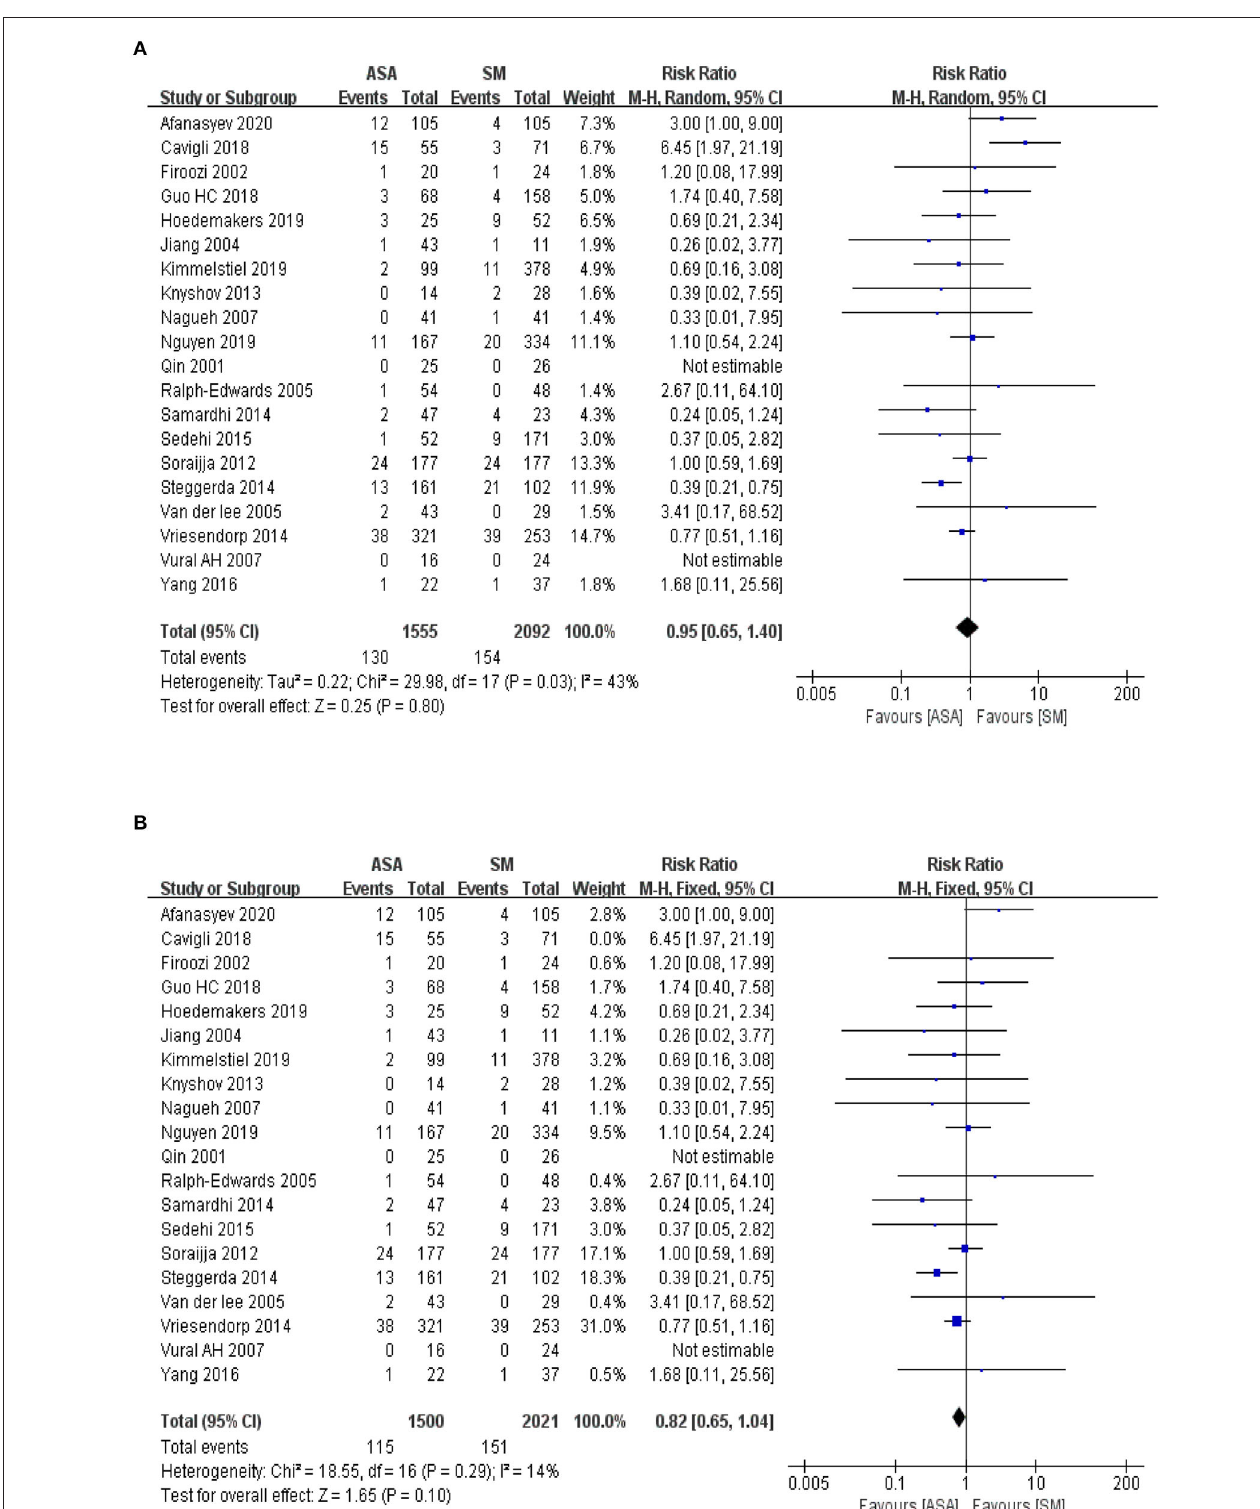
FIGURE 2 | (A) The forest map for the meta-analysis of all-cause mortality. M-H, Mantel-Haenszelt test; CI, confidence interval; Random, random effect model. (B) The adjusted forest map for the meta-analysis of all-cause mortality. M-H, Mantel-Haenszelt test; CI, confidence interval; Fixed, fixed effect model.